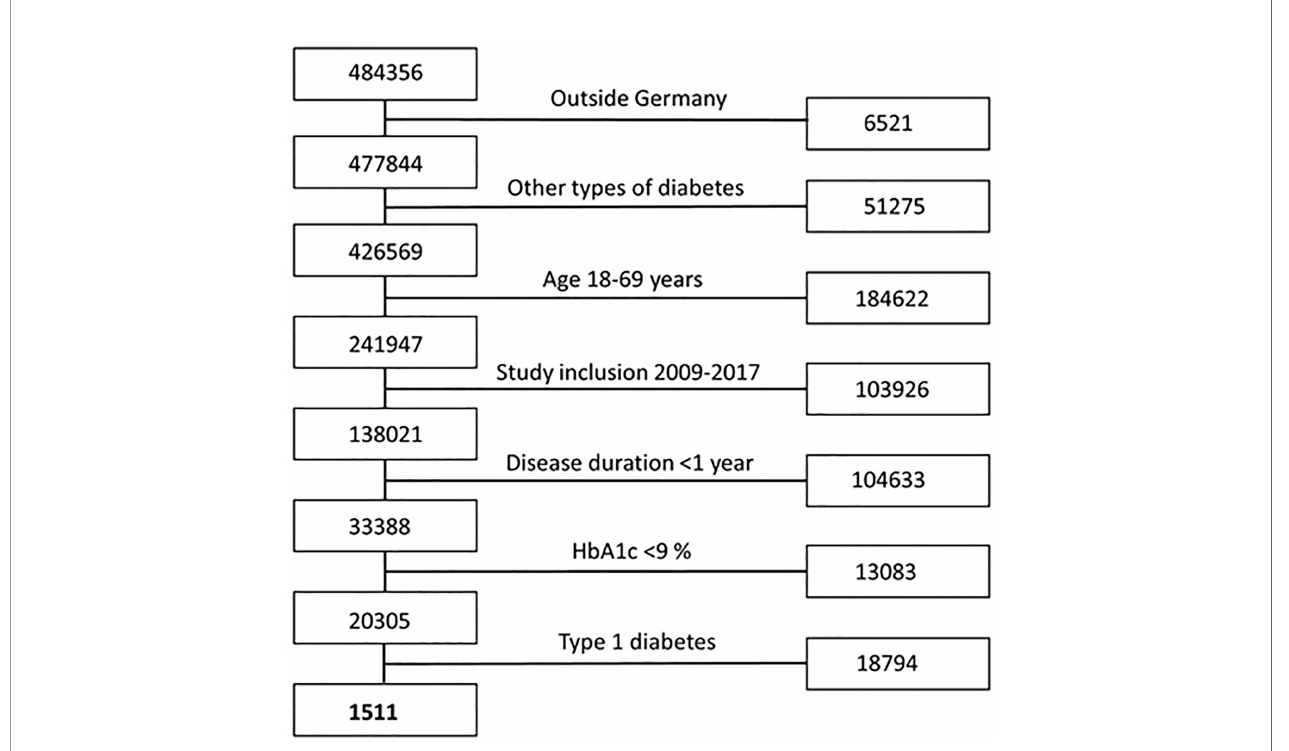
FIGURE 1 | Flow chart participants ’ selection criteria for the DPV registry. Flow chart showing the included and excluded participants of the DPV registry based on selection criteria matching the inclusion criteria of the GDS.